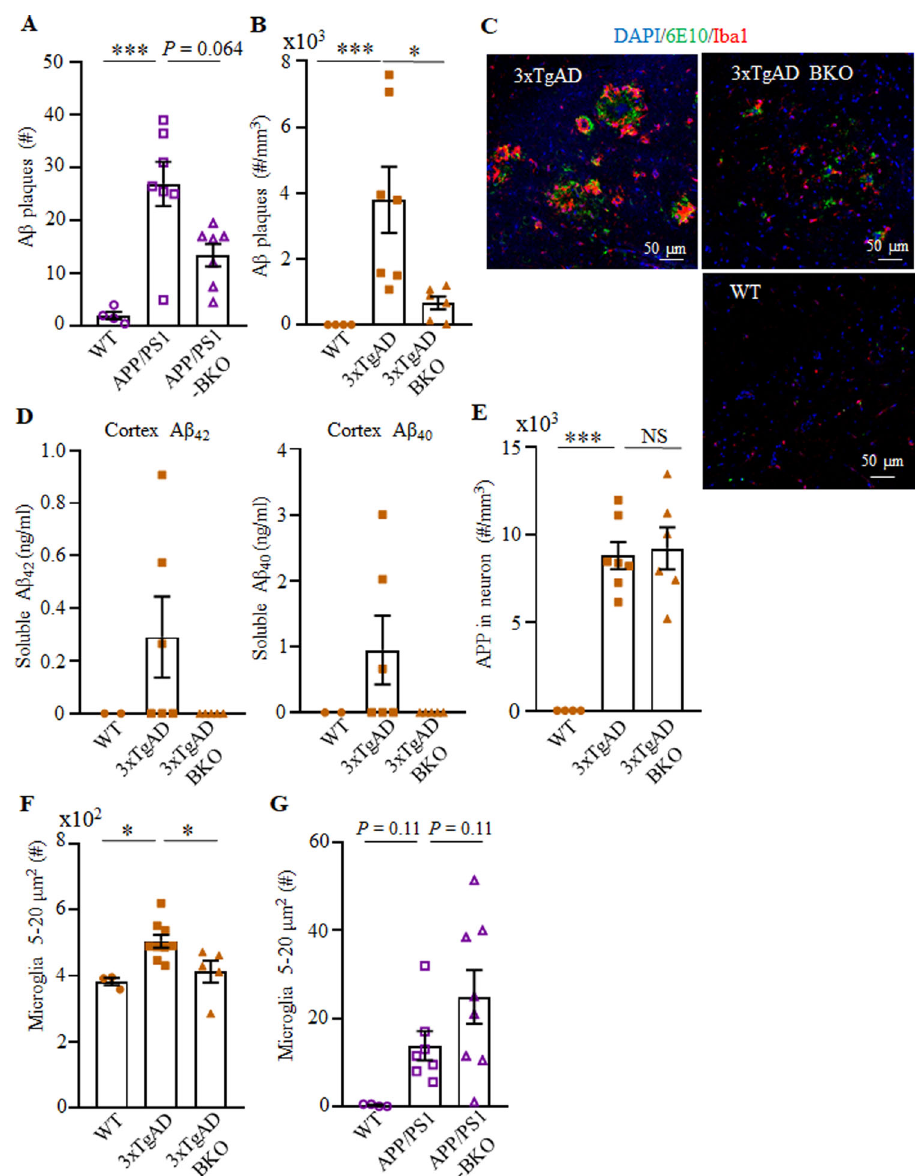
Fig. 3 B-cell de fi ciency reduced the A β plaque burden and microglial activation in the hippocampus of AD mice. A – C show the number of A β plaques in APP/PS1 ( A ) and 3×TgAD ( B ) mice ( n = 4 – 7), and representative images of immune fl uorescent staining of the subiculum of WT, 3×TgAD, and 3×TgAD- BKO mice ( C , A β plaque (green), Iba1 + microglia (red), and DAPI (blue); scale, 50 μ m). D The increase of soluble A β 1 – 40 and A β 1 – 42 peptides in the brain of 3×TgAD mice was reversed in 3×TgAD-BKO mice. The results of ELISA in the cortex of indicated mice ( n = 2 – 6) are shown. The B-cell de fi ciency did not affect expression of the transgene, as both 3×TgAD and 3×TgAD-BKO highly expressed transgenic hAPP in hippocampal neurons ( E , stained with 6E10 as in B – C ). The B-cell de fi ciency signi fi cantly decreased the number (#) of large-sized microglia (5 – 20 μ m 2 ) in 3×TgAD ( n = 3 – 9, F ), but not in APP/PS1 mice ( n = 4 – 8, G ). Mean± SEM is shown; each symbol is for a single mouse. * p < 0.05; *** p < 0.001; NS not signi fi cant in Kruskal – Wallis test ( A , B , G ) or one- way ANOV A ( E , F